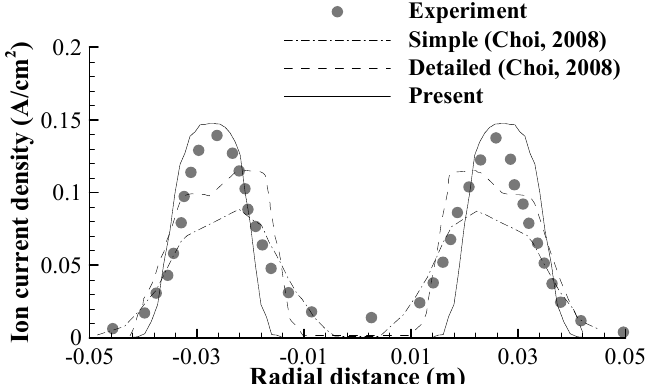
Figure 7. Radial profiles of the ion current density at x = 10 mm for Case 1.